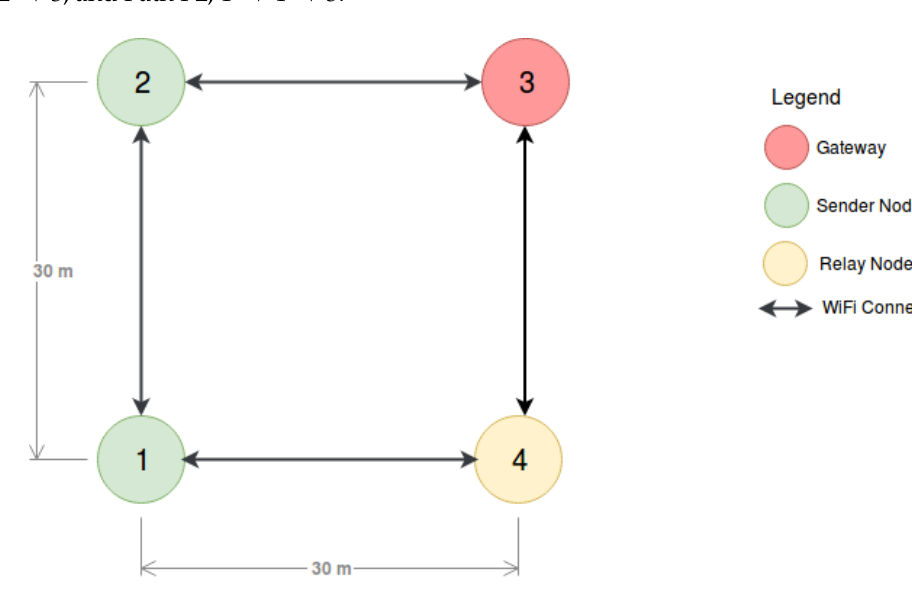
Figure 13. Aquatic Scenario